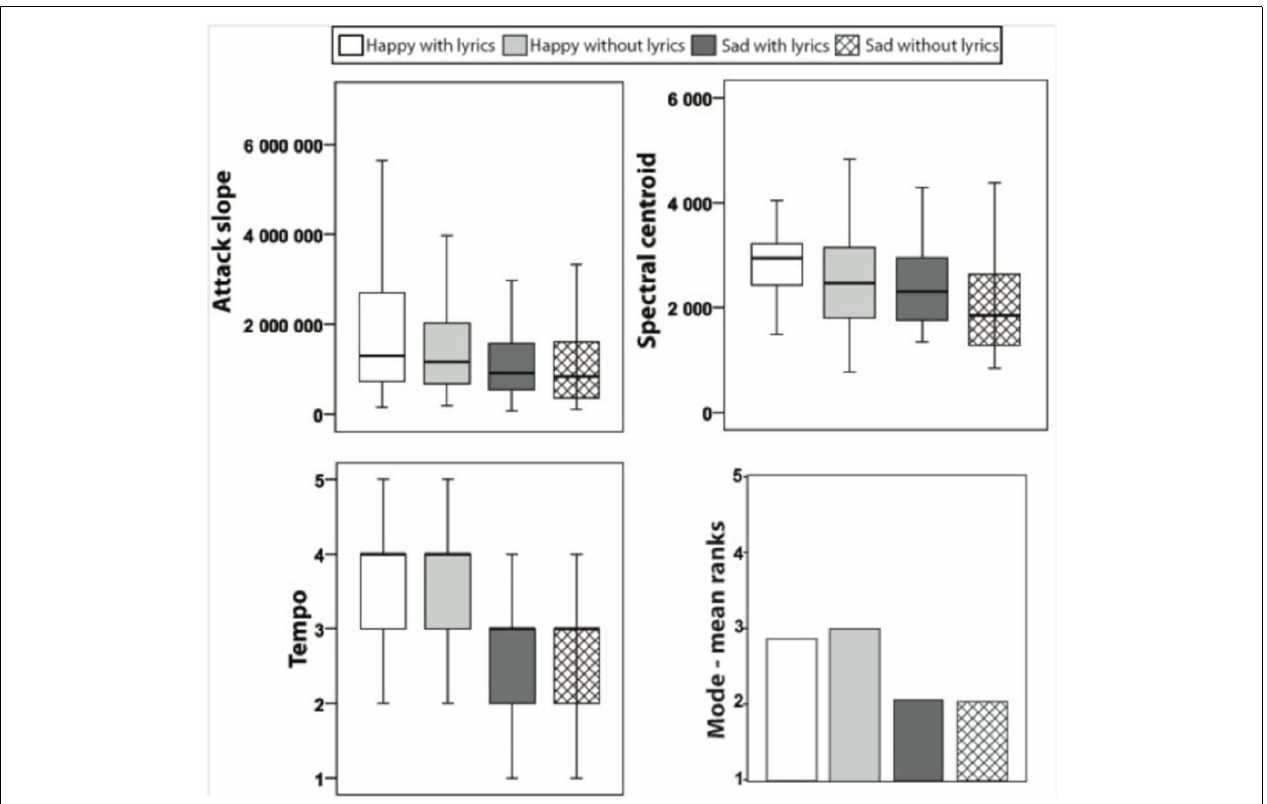
FIGURE 1 | Box plots with quartiles (upper values 75%, median 50%, and lower values 25%) for the attach slope and spectral centroid in each stimulus category. Outliers and extreme values are excluded.